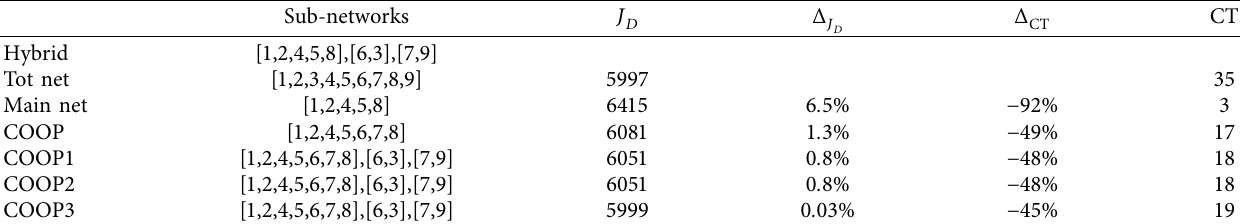
Table 6: Decentralized vs centralized with Hybrid decomposition based on